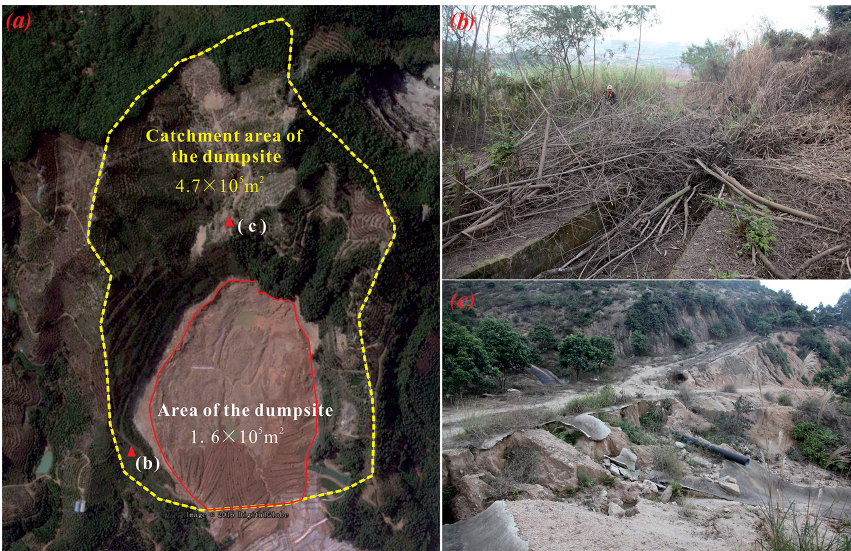
Figure 5. (a) Overview of the catchment area (Google Earth image); (b) the surrounding peripheral drainage channel of the dumpsite was abandoned; (c) damaged drainage pipes were not repaired and failed to divert surface runoff into the peripheral drainage channel. Surface runoff concentrated in the waste filling.